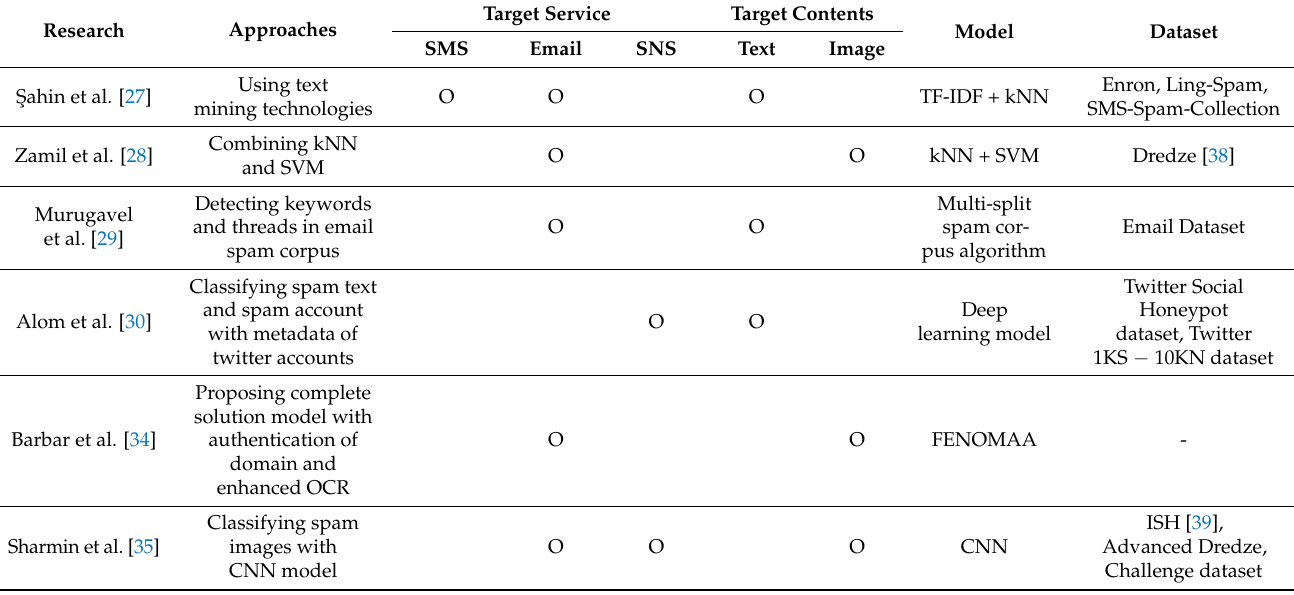
Table 1. A comparison with related